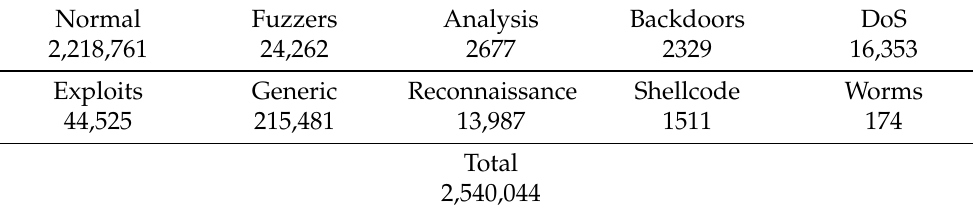
Table 2. UNSW-NB15 record distribution. Normal traffic accounts for 87% of the total, while some attacks are <0.00005% (i.e., Shellcode and